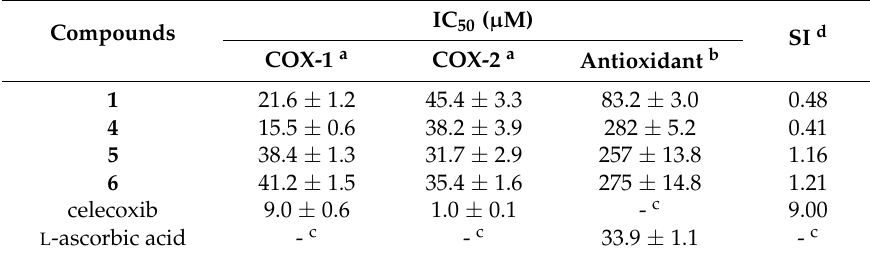
Table 3. In vitro COX-1/COX-2 inhibition and antioxidant activities of isolated compounds.